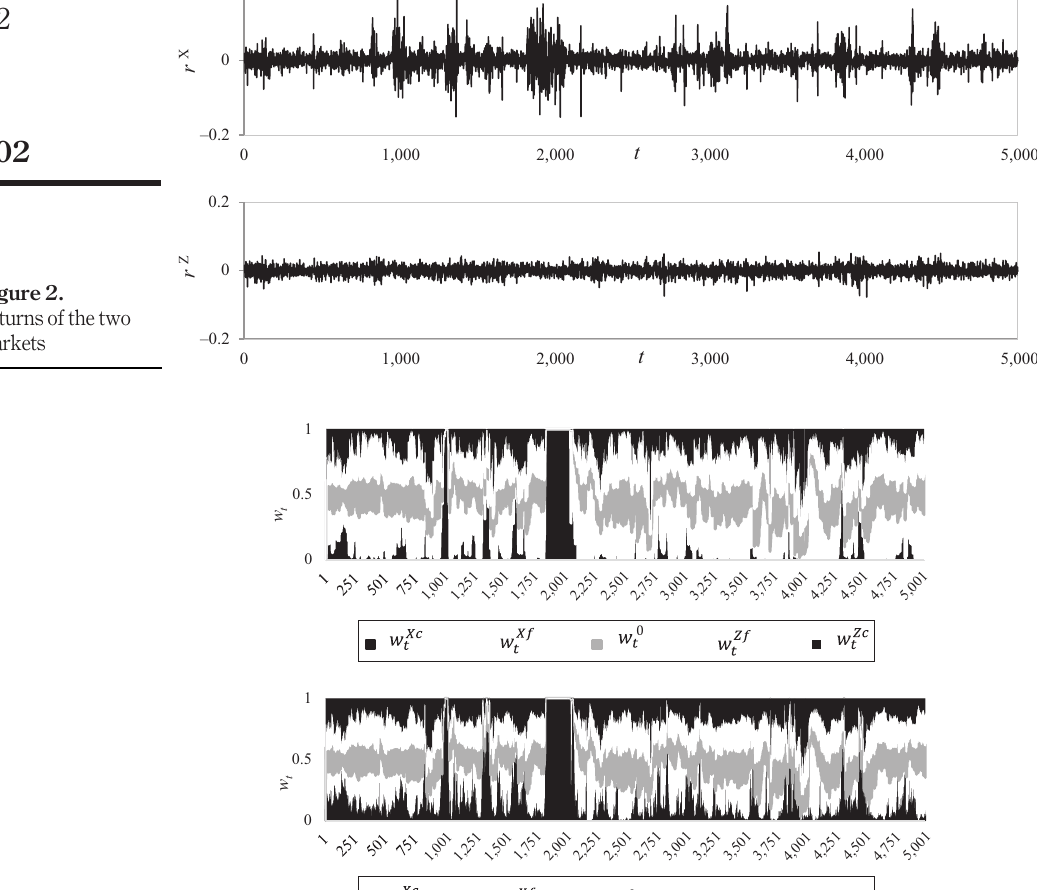
Figure 2. Returns of the two markets Figure 3. Weights of trading strategies